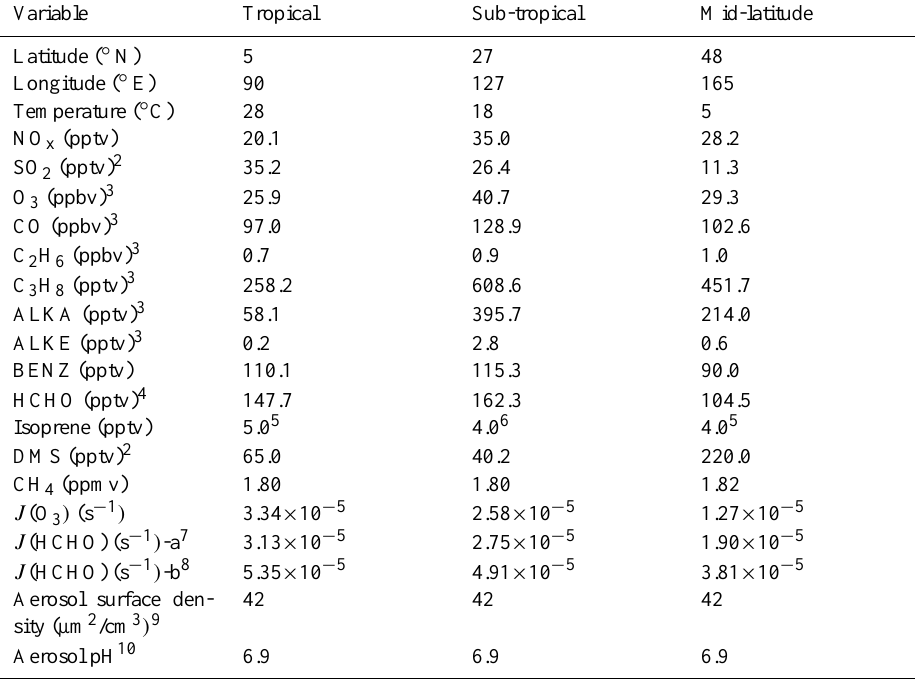
Table 2. Simulation conditions for the constructed case studies 1